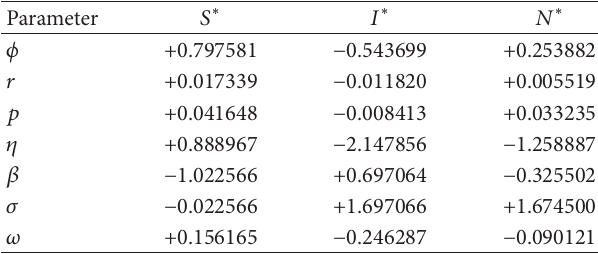
Table 4: Sensitivity indices of 𝐸 ∗ with 𝜙 = 0.8